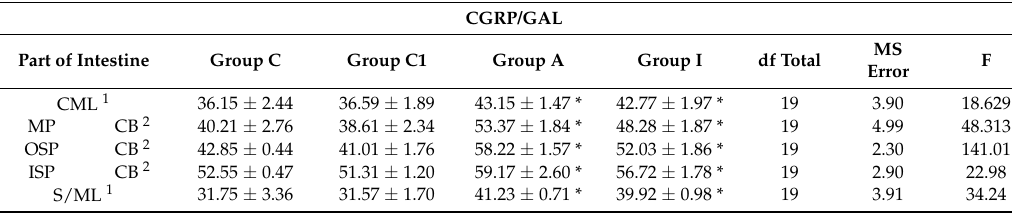
Table 6. Co-localization of CGRP with galanin (GAL) in the enteric nervous structures of the porcine descending colon under physiological conditions (Group C), after “sham” operation (Group C1), after axotomy (Group A) and during inflammation (Group I). CGRP/GAL Part of Intestine Group C Group C1 Group